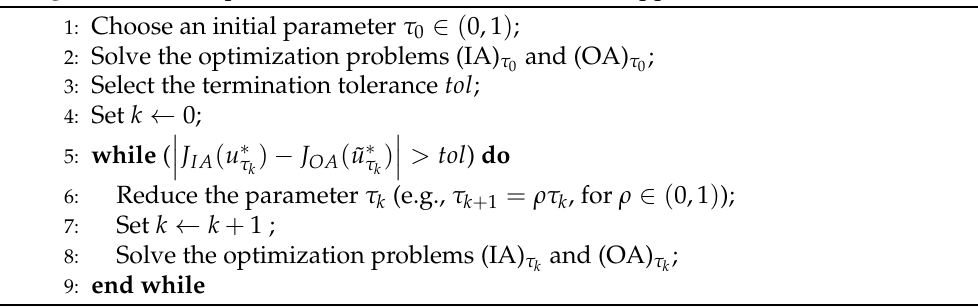
Algorithm 1: Computation scheme for the inner–outer approximation